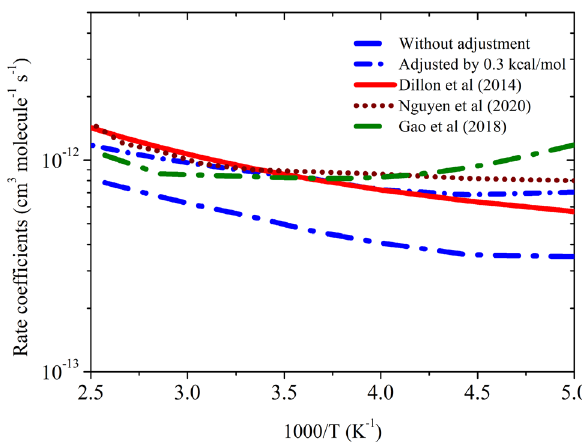
Figure 9. Rate coefficients for OH + CH 3 OH